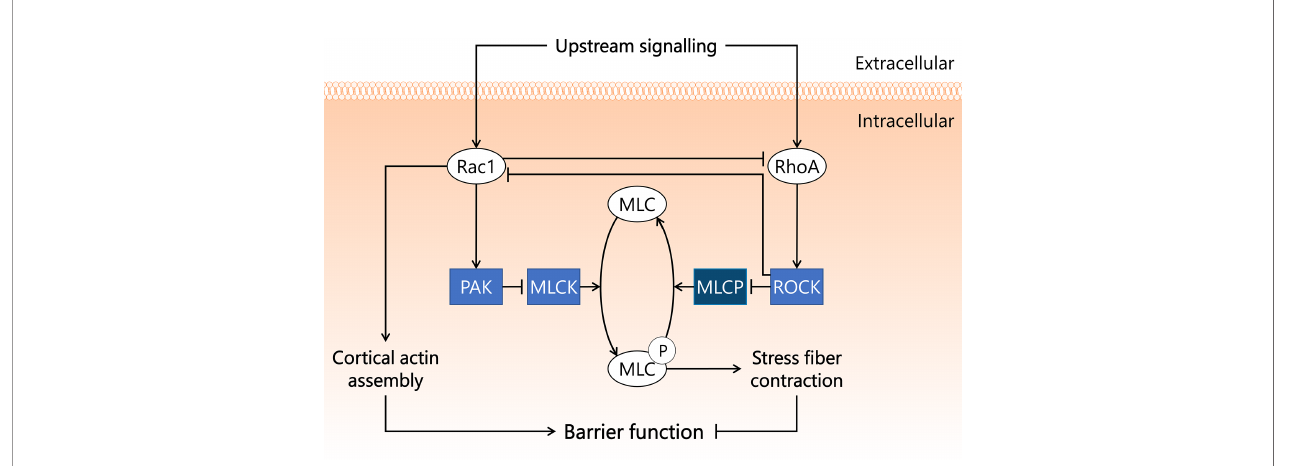
FIGURE 2 | Rac1 and RhoA GTPases exert opposite effects on endothelial barrier function in sepsis. Endothelial barrier integrity is integral for maintaining blood pressure and preventing microvascular leakage and subsequent tissue hypoxia. Rac1 and RhoA GTPases both play important roles in endothelial barrier function, and are activated by a variety of upstream signals associated with sepsis. Rac1 inhibits RhoA and inhibits MLCK in a PAK-dependent manner. RhoA activates its effector kinase ROCK, which inhibits Rac1 activity and phosphorylates MLCP, resulting in inactivation. MLCK induces phosphorylation of MLC, a process reverted by MLCP. Upon phosphorylation, MLC induces the formation and contraction of stress fi bres in the cell, leading to reduced cell-cell contacts and dysregulated endothelial barrier function. Activated Rac1 stimulates the assembly of cortical actin, which preserves endothelial barrier function. MLC, myosin light chain; MLCK, myosin light chain kinase; MLCP, myosin light chain phosphatase; PAK, p21-activated kinase; Rac1, Ras-related C3 botulinum toxin substrate 1; RhoA, Ras homolog gene family, member A; ROCK, Rho-associated protein